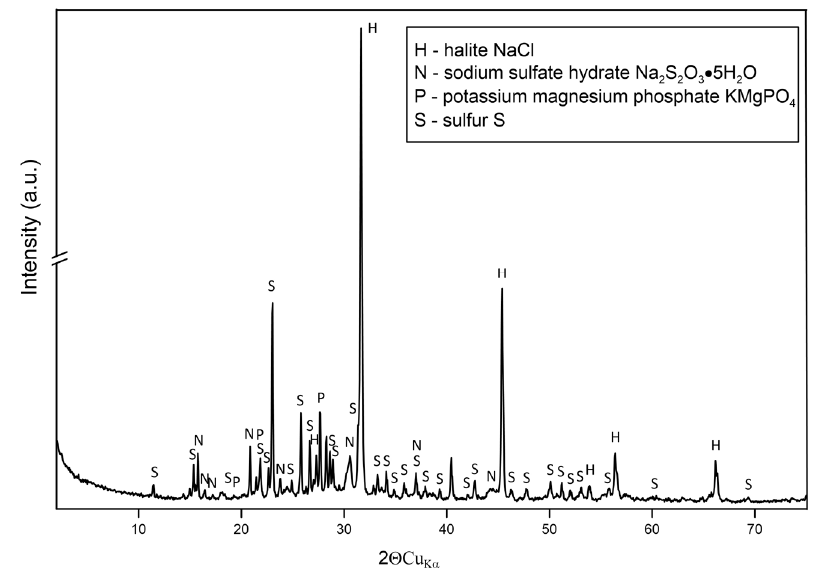
Figure 5. X-Ray Diffraction pattern of the collected sediment from the reactor after 5 days of